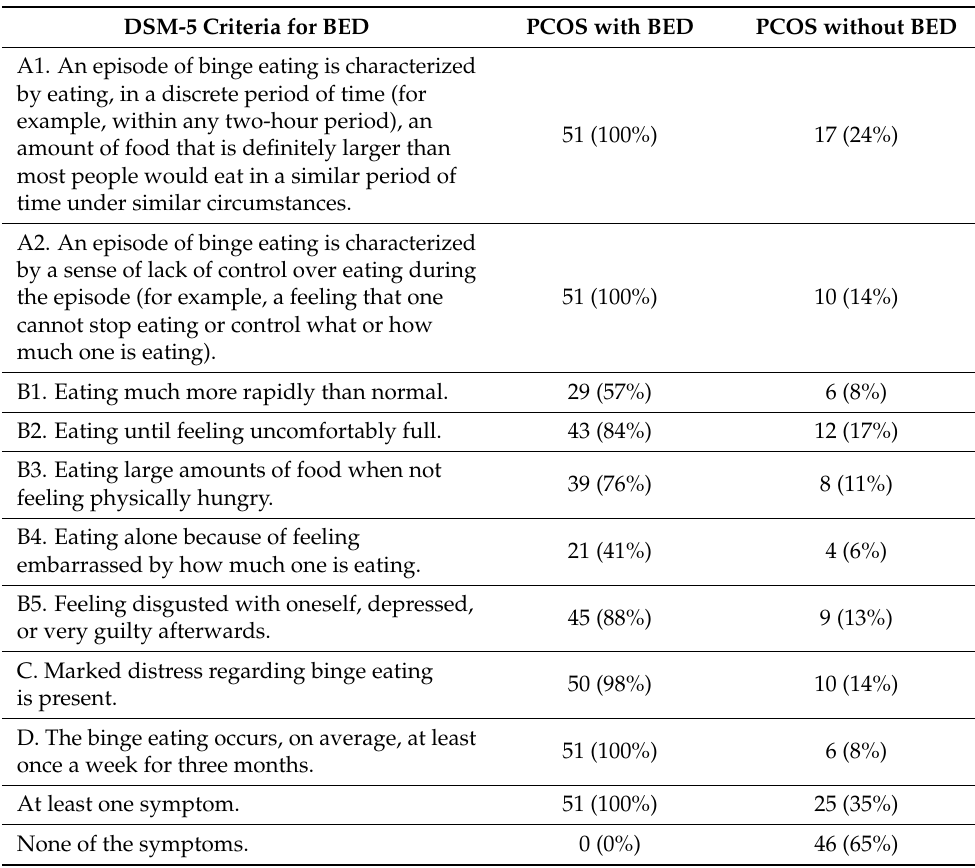
Table 1. The prevalence of BED symptoms of among subjects with and without BED in the study group. DSM-5 Criteria for BED PCOS with BED PCOS without BED